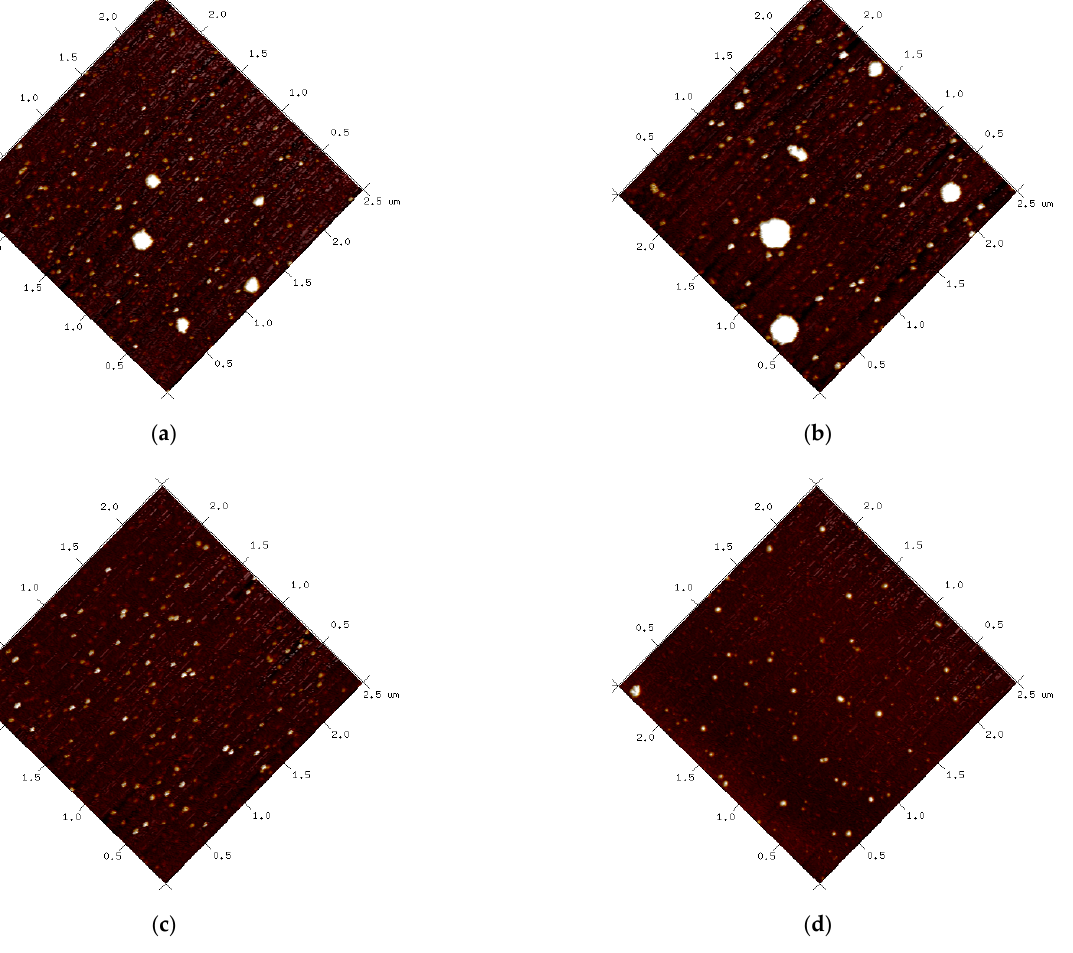
Figure 7. AFM images. ( a ) SPI; ( b ) SPI-LNPS at a mass ratio of 100:3 between protein and lutein; ( c ) PSPI; ( d ) PSPI-LNPS at a mass ratio of 100:3 between protein and lutein.